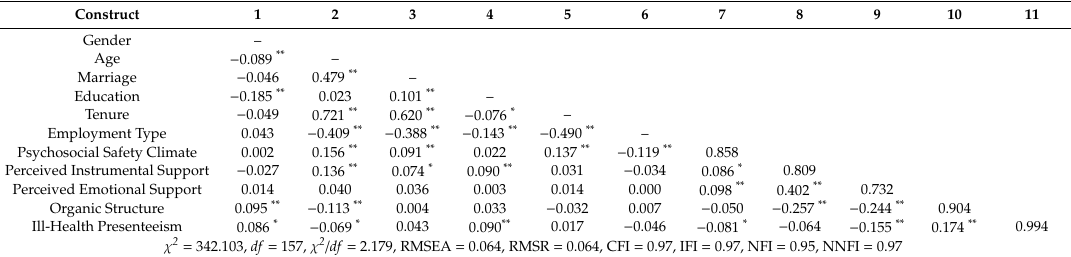
Table 2. Correlation coe ffi cients between each construct.